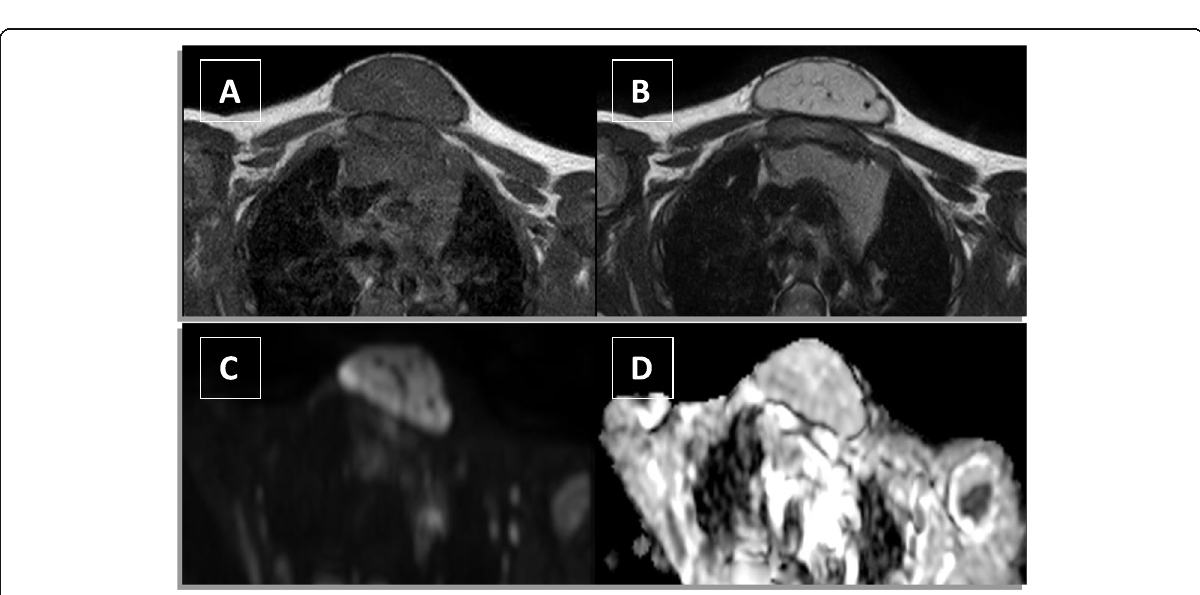
Fig. 4 A 10-year-old male patient presented with anterior midline pre-sternal chest wall mass. MRI chest wall shows a well-defined oval shaped soft tissue mass with related dilated vascular channels and no intra-thoracic extension, eliciting hypointense signal intensity in T1WI ( a ) and high signal intensity in T2 WI ( b ) with facilitated diffusion pattern in diffusion WI ( c ) and ADC map ( d ). The ADC value was 2.08 ± 0.05 × 10 − 3 mm 2 /s, and the mass was pathologically proven to be